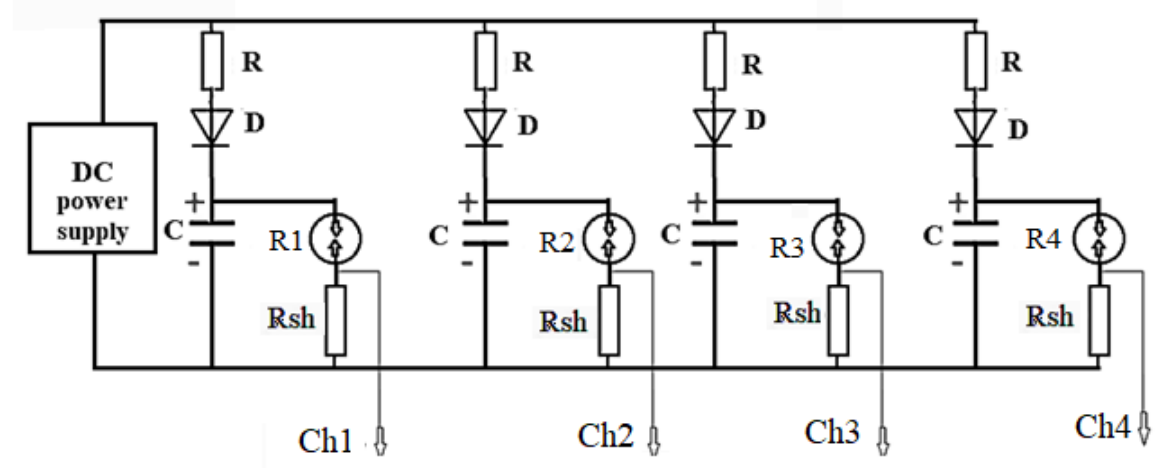
Figure 12. NTP scale-up using R–C pulse generator (RCG).